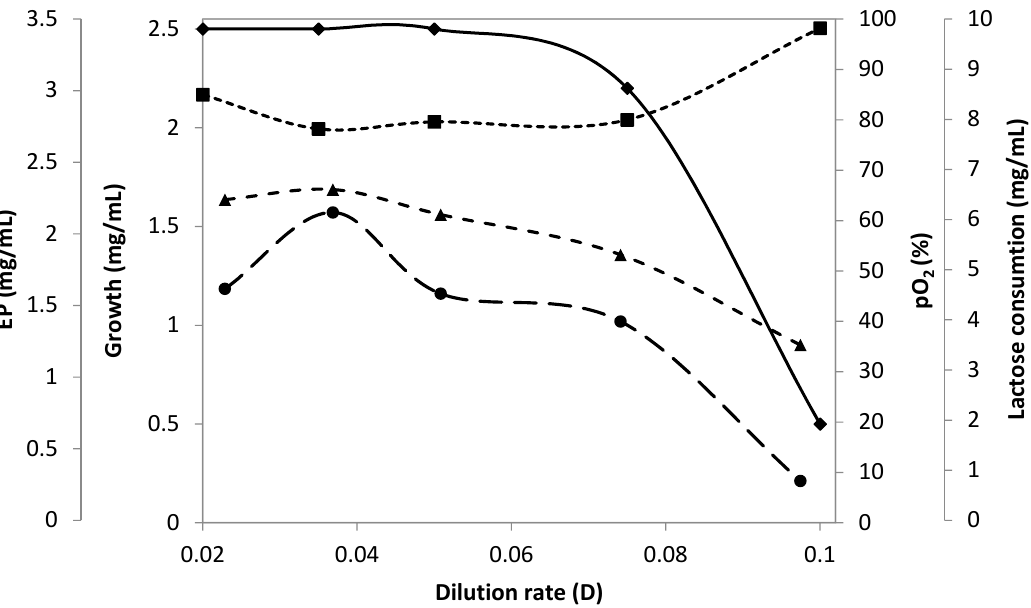
Figure 1. Effect of dilution rate on growth ( ♦ ) and exopolymer (EP) production ( ● ) during the continuous cultivation of C. canadensis 28 in a stirred-tank fermenter at aeration of 1.0 vvm and agitation rate 900 rpm. Changes in the consumed lactose ( ▲ ) and dissolved oxygen ( ■ ) were registered.